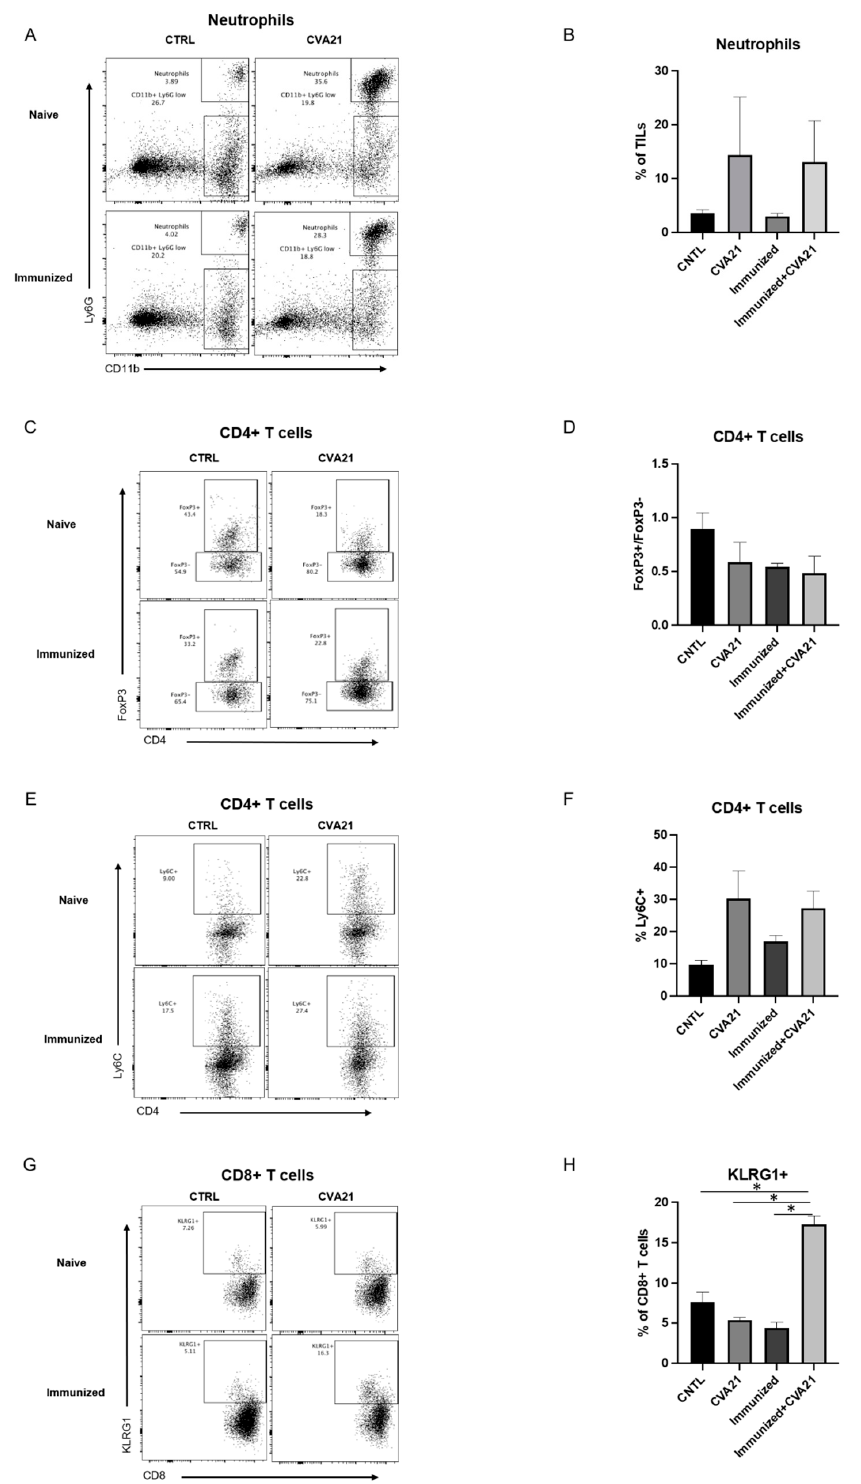
Figure 5. Tumor immune cell profiling by flow cytometry in naïve and immunized mice. Cells were extracted from tumors treated with saline or CVA21 in naïve or immunized (i) mice. Ly6G and CD11b were used as markers of neutrophils ( A , B ). FoxP3, Ly6C, and KLRG1 were used to evaluate T cell activation ( C – H ). Density plots and quantitation are shown for neutrophils ( A , B ), CD4+ T-cells ( C – F ), and CD8+ T-cells ( G , H ). Data were collected from 3 naïve and 3 immunized mice per treatment group. Error bars represent the standard error of the mean (SEM) between the replicates. p values < 0.05 were considered significant ( p < 0.05